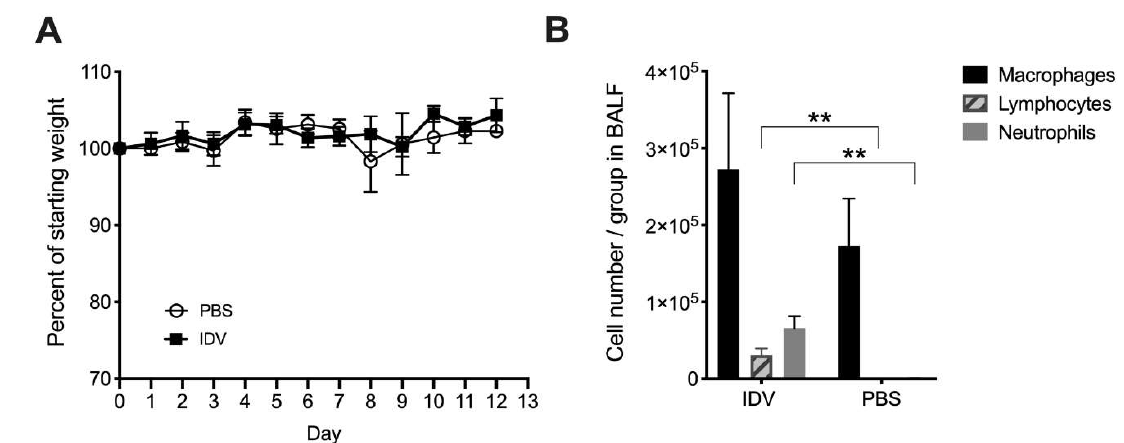
Figure 1. Primary IDV infection in C57BL/6 wildtype (WT) mice. ( A ) C57BL/6 (WT) mice were inoculated with OK11 (IDV; black boxes) or PBS (open circles) on day 0. Percent initial body weights (compared to day 0) were measured each day; ( B ) Differential counts of white blood cells from BALF were measured on day 7 (when secondary bacterial infections are known to be detrimental). Experiments had a minimum of 5 animals per group and were repeated two times. Data are represented as mean ± SD, and ** indicates p < 0.01 between indicated groups using Student’s t test.